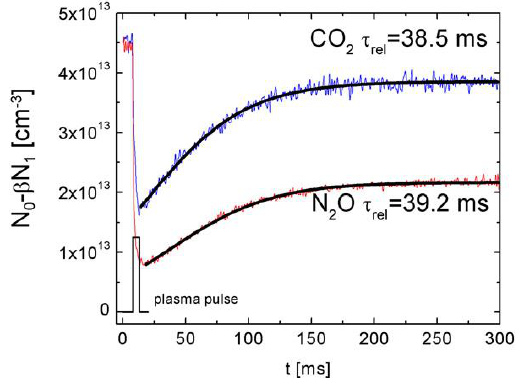
Figure 9. Time evolution of the absorption signals of CO 2 and N 2 O measured simultaneously in a pulsed dc discharge at p = 133 Pa, I = 50 mA, τ = 5 ms. A fit of the experimental data is also shown. [52], © IOP Publishing. Reproduced with permission. All rights reserved.